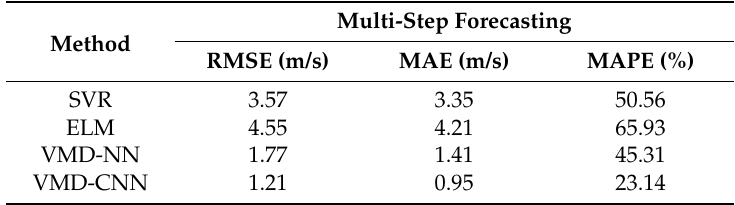
Table 6. Multi-step forecasting results of models in Sotavento Galicia wind